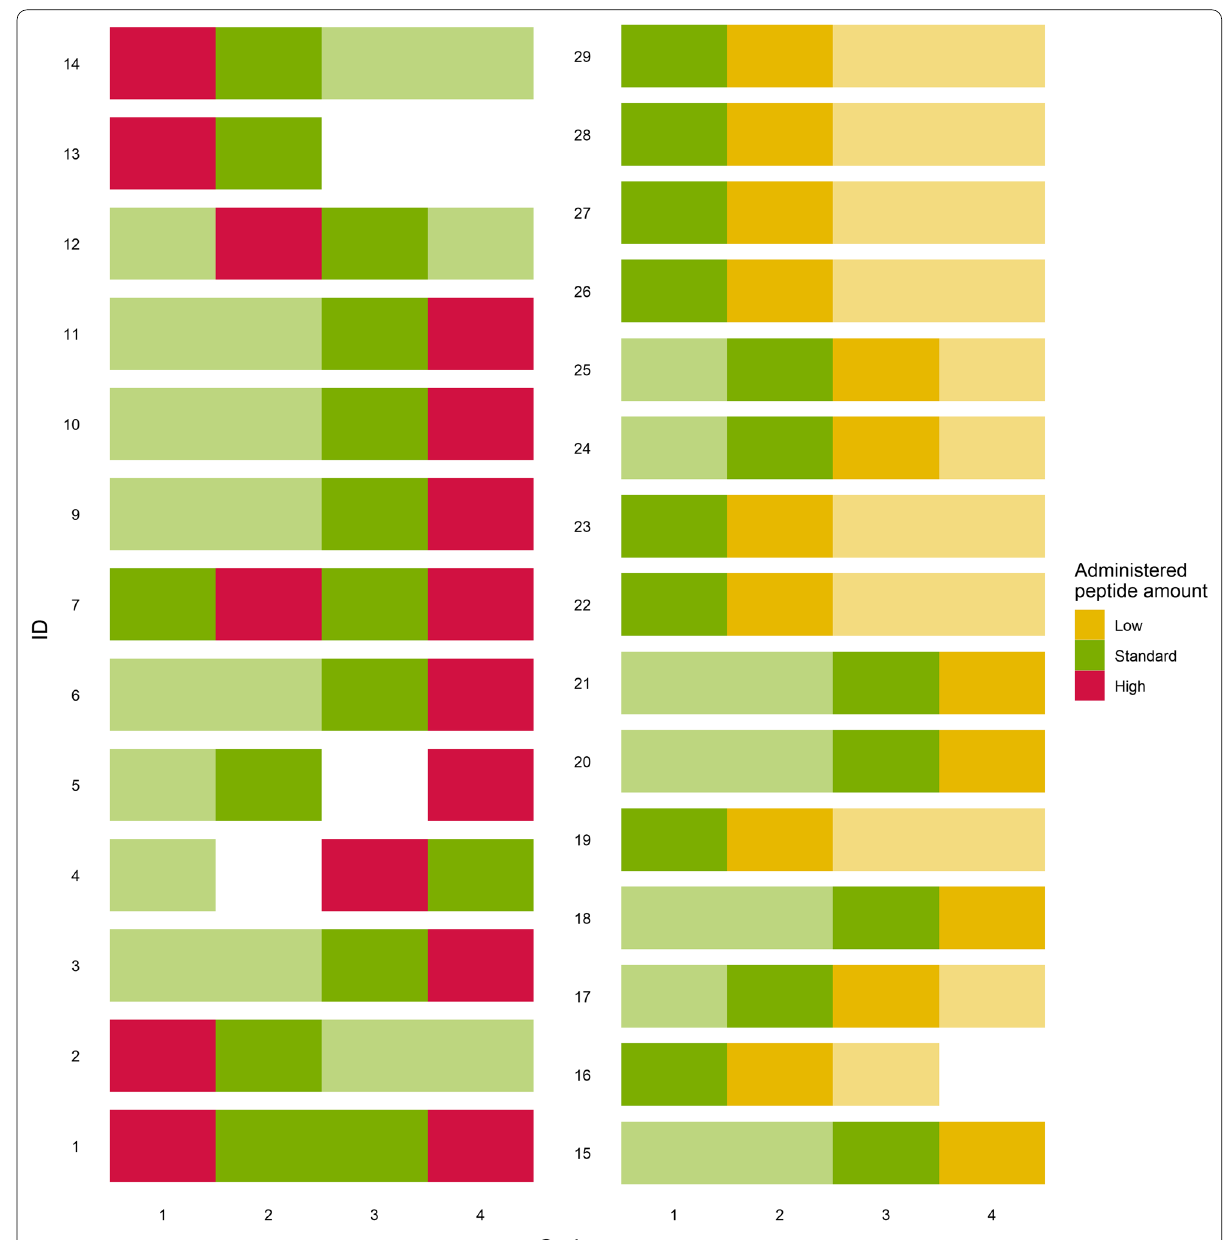
Fig. 1 Overview of low, standard or high administered peptide amount of [ 177 Lu]Lu‑HA‑DOTATATE per cycle for each patient, where dark colored blocks represent included cycles for paired Wilcoxon